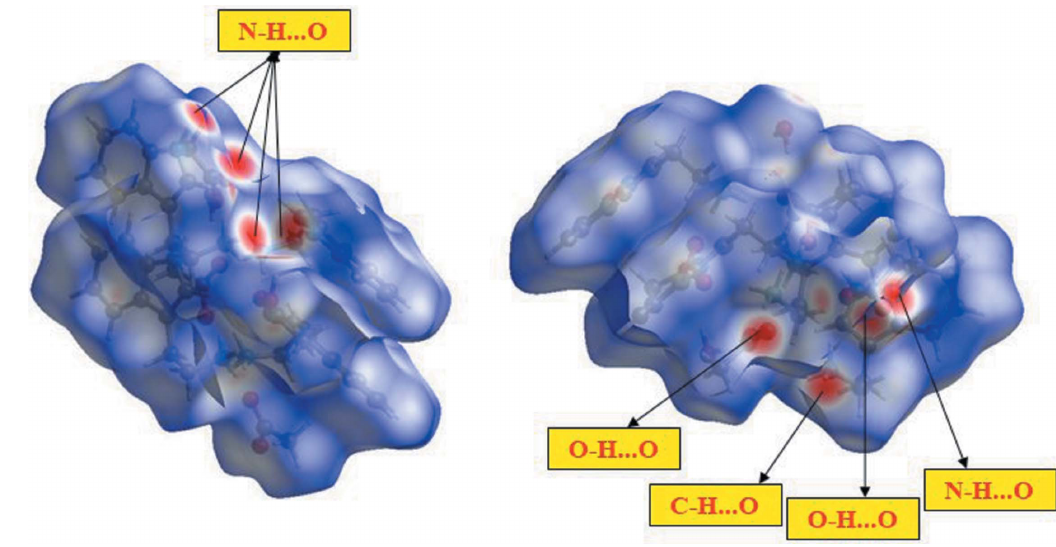
Figure 3 Two views of the overall Hirshfeld surface mapped over d norm for the title molecular salt.